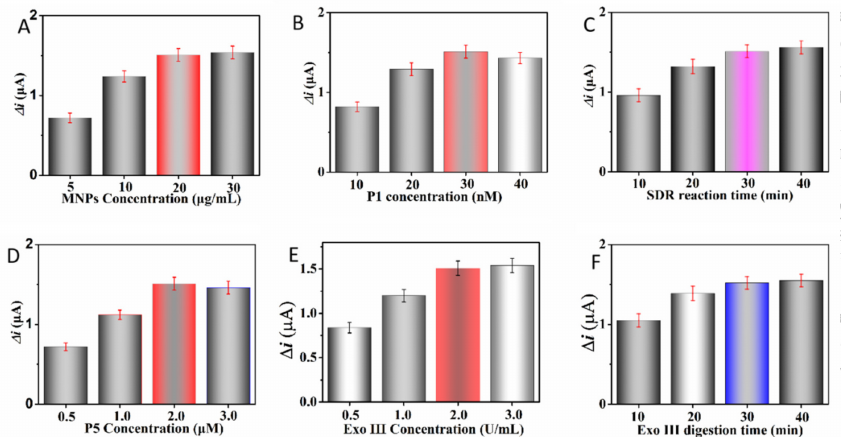
Figure 2. ( A ) Concentration of MNPs; ( B ) concentration of P1; ( C ) reaction time of SDR; ( D ) concen- tration of P5; ( E ) concentration of Exo III; ( F ) digestion time of Exo III; error bars: SD, n = 3.